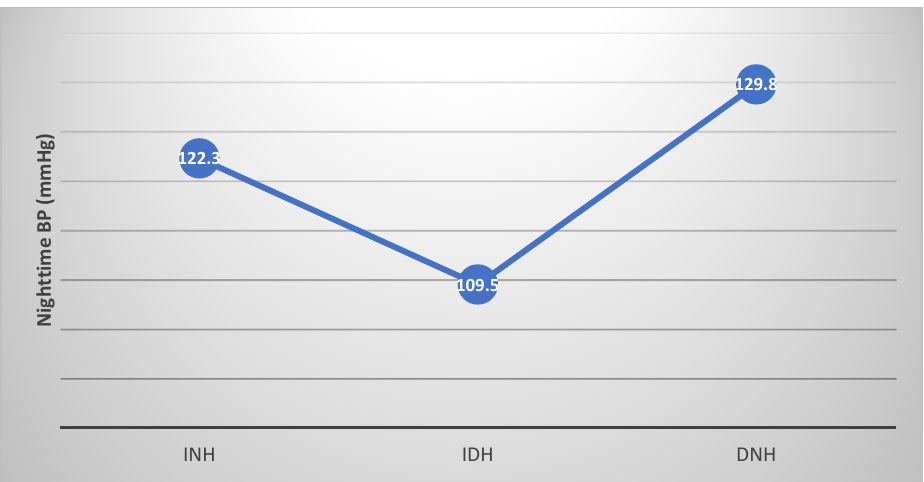
Figure 4. Nighttime systolic blood pressure among the three blood pressure categories: isolated nocturnal hypertension, isolated diurnal hypertension, and day-night hypertension. BP, blood pressure; INH, isolated nocturnal hypertension; IDH, isolated diurnal hypertension; DNH, day-night hypertension. p < 0.001 for all three comparisons (one-way ANOVA test with Bonferroni correction).